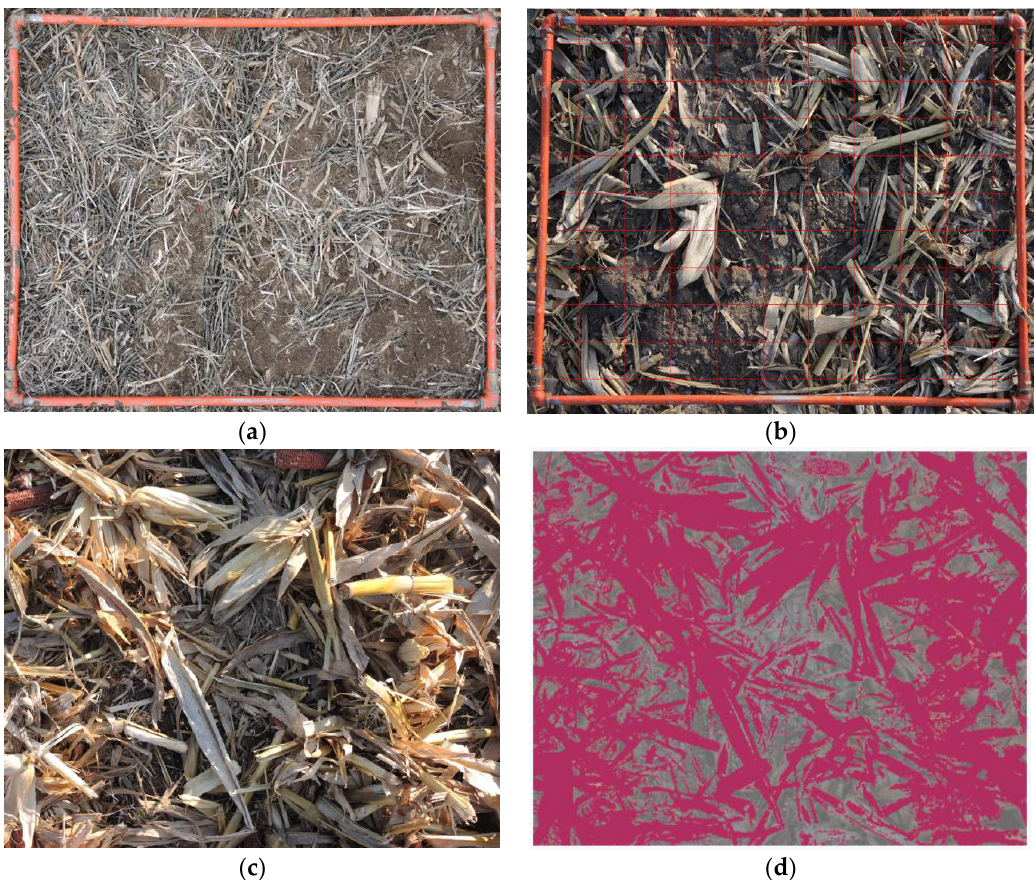
Figure 2. Examples of vertical photographs taken over soybean ( a ) and corn ( c ) fields. The photograph-grid method used superimposed, uniformly spaced 10 by 10 digital grid intersections ( b ). The app estimated crop residue is displayed in ( d ) as a thematic classified map using a two-color palette legend (residue class in red vs. no-residue class in gray. ( c,d ) show an example of the app method input and output. This example shows an evident underestimation of the app-derived crop residue compared to that from the photograph-grid method (i.e., 62% vs. 88%, respectively).